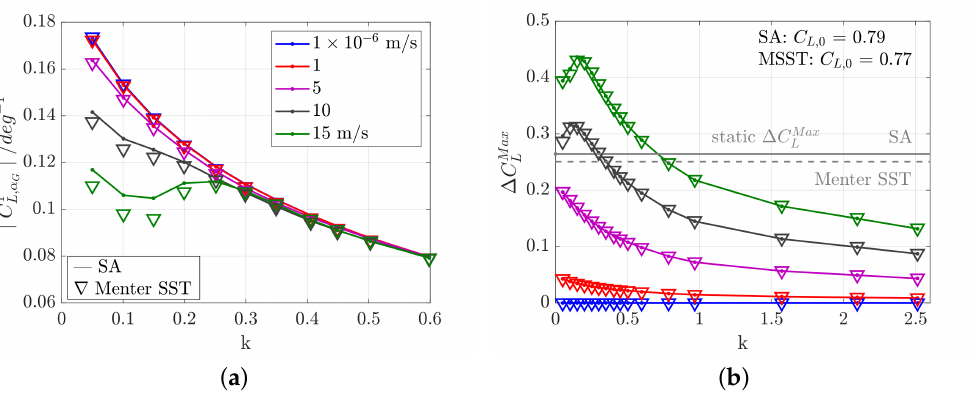
Figure 16. Global variables in comparison between Spalart-Allmaras (solid lines) and Menter SST (symbols) at Mach 0.70. ( a ) First harmonic of the lift FRF, ( b ) Maximum